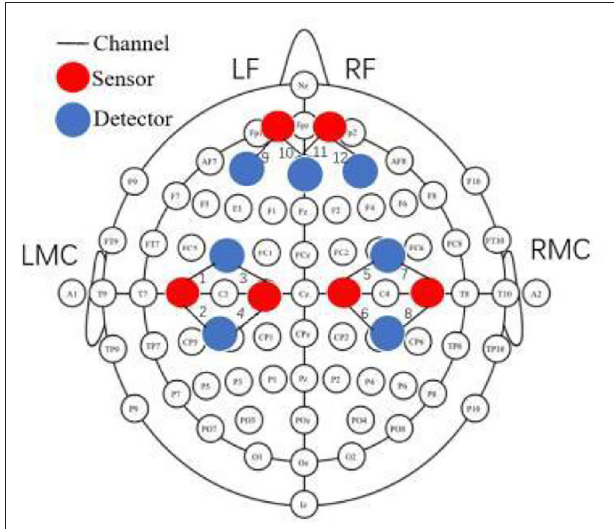
FIGURE 3 | Functional near-infrared spectroscopy (fNIRS) 12-channel montage configuration. The probes were located over the frontal cortex (left frontal cortex and right frontal cortex near FP Z ), the primary motor cortex (M 1 ) (left M 1 and right M 1 ). The red circles represent the positions of sensors (S) and the blue circles represent the positions of detectors (D). The line between them is the channel. LMC, left M 1 cortex; RMC, right M 1 cortex; LF, left frontal cortex; RF, right frontal cortex.